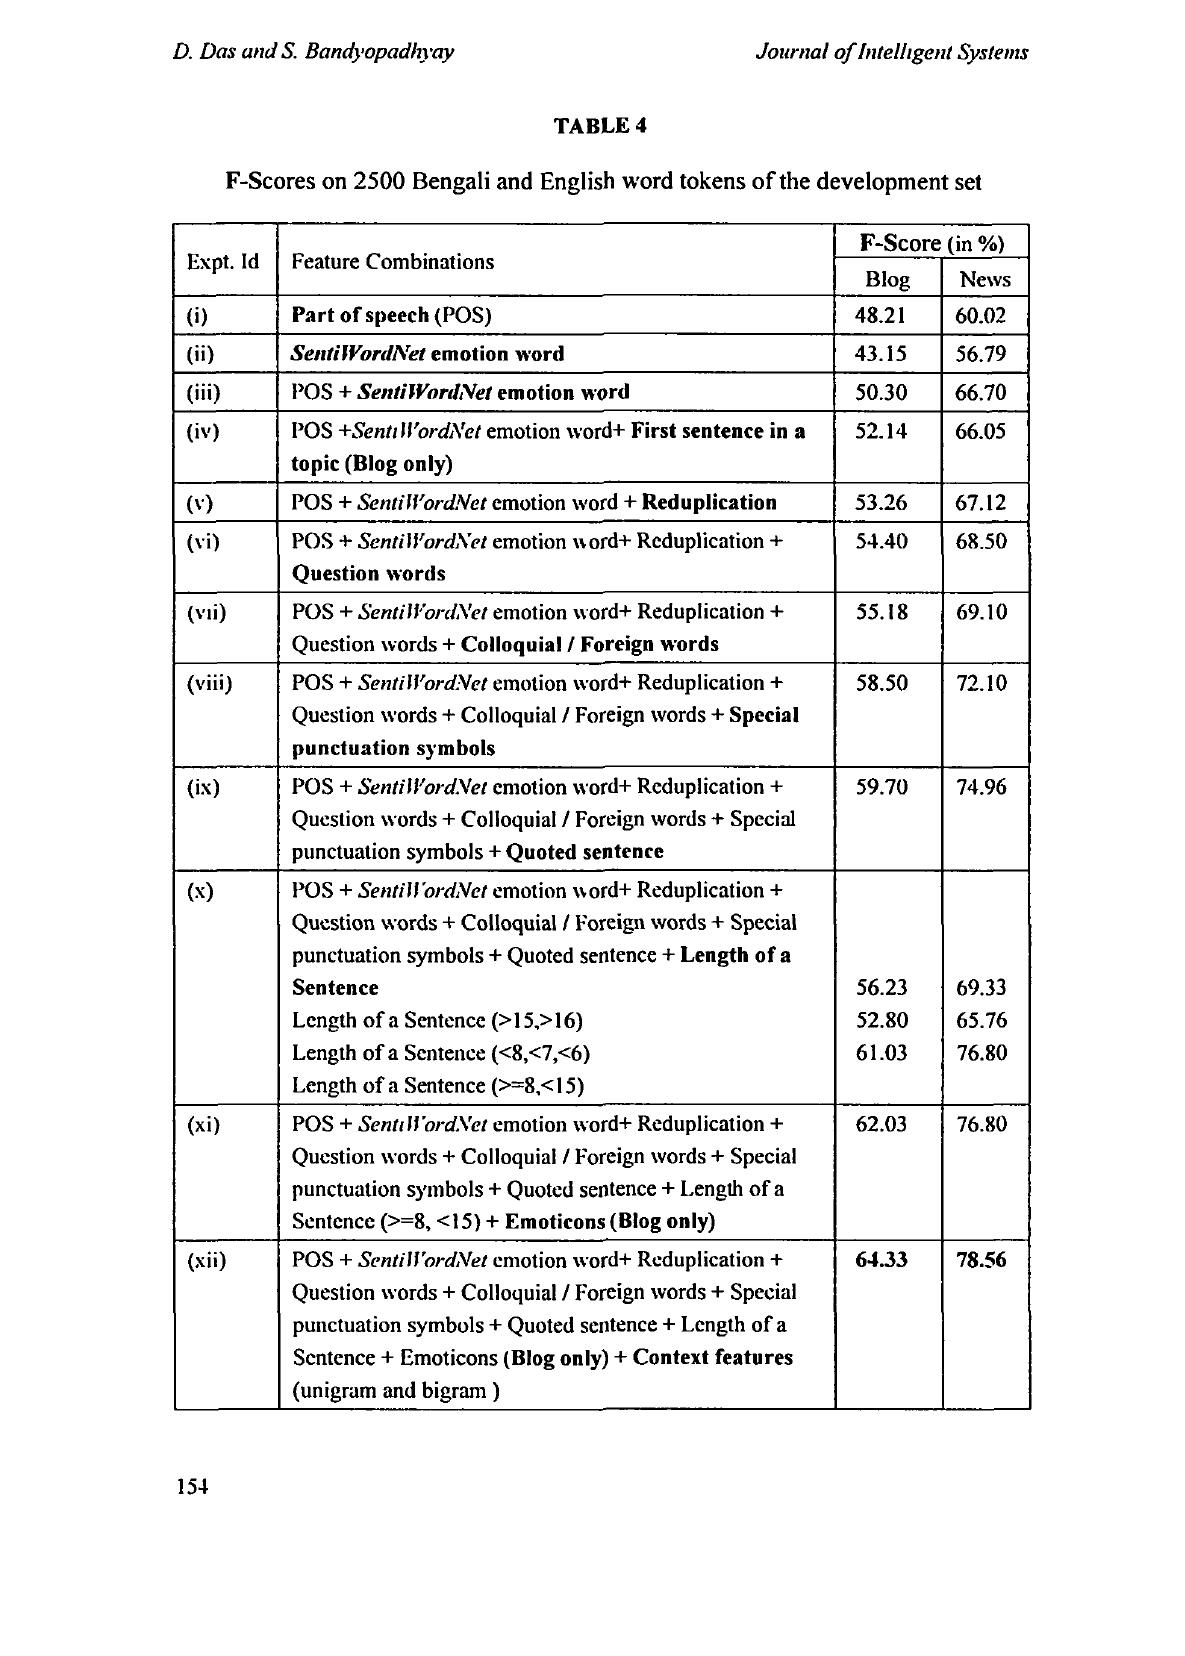
F-Scores on 2500 Bengali and English word tokens of the development